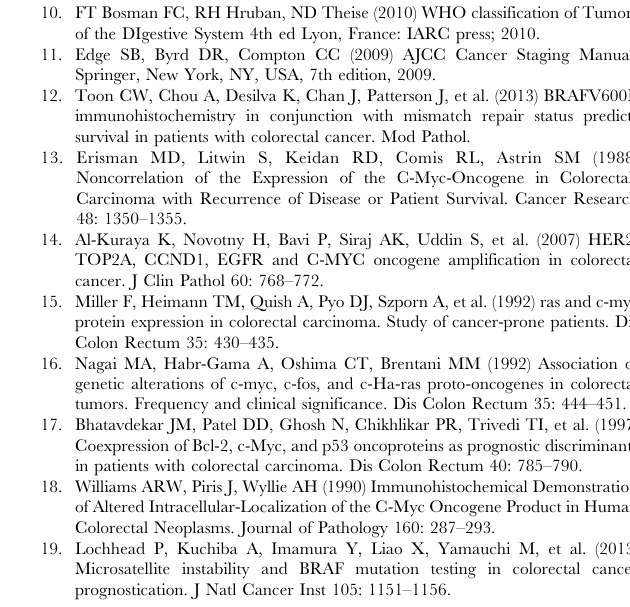
Figure 2. Myc IHC on whole section CRCs from 2004, confirming TMA findings. Panel A: Kaplan Meier curves showing superior overall survival of CRCs with MYC over-expression compared to myc negative CRCs (Log Rank test p , 0.01); Panel B: Univariable Cox regression